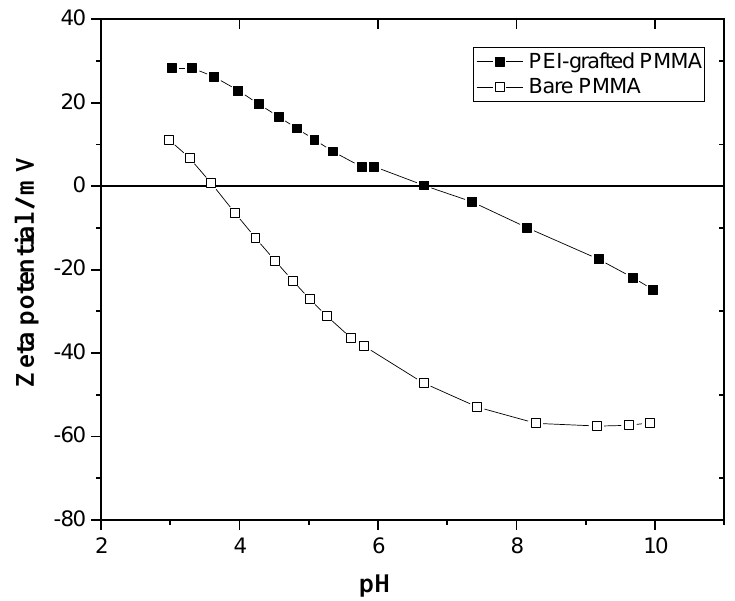
Figure 8. Zeta potential versus pH of bare PMMA and PEI-grafted PMMA.